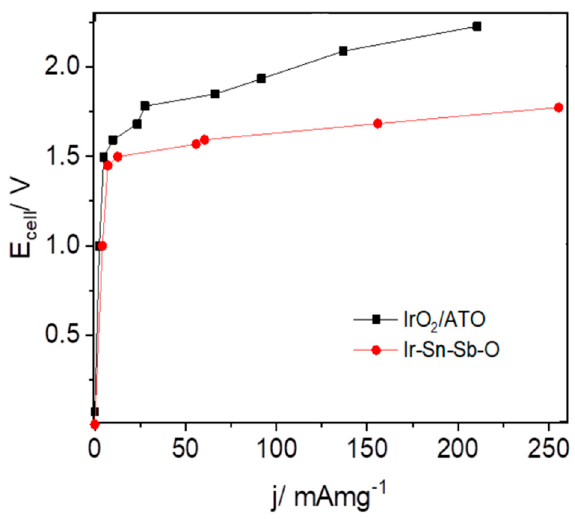
Figure 10. Polarization curves of IrO 2 /ATO ( ∎ ) and Ir-Sn-Sb-O ( ● ) at 70 °C and 7 mL min − 1 of water.